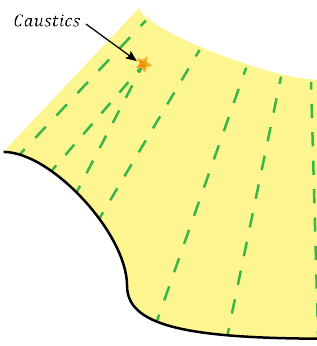
Figure 4 . Caustics are formed on a null geodesic congruence when nearby null generators